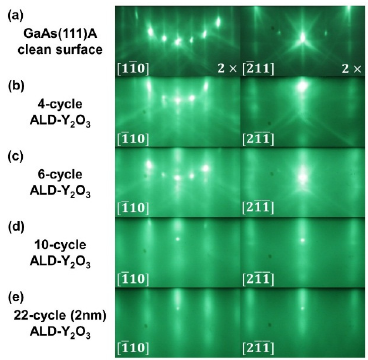
Figure 2. In-situ RHEED patterns of ( a ) freshly MBE grown GaAs(111)A-2 ˆ 2, and subsequent growth of ALD-Y 2 O 3 (111) films ( b ) 4-cycle ALD-Y 2 O 3 ; ( c ) 6-cycle; ( d ) 10-cycle; and ( e ) 22-cycle (2 nm). The zone axes for left panel are, respectively, GaAs[110] and ALD-Y 2 O 3 [110], and for the right panel are GaAs[211] and ALD-Y 2 O 3 [211],